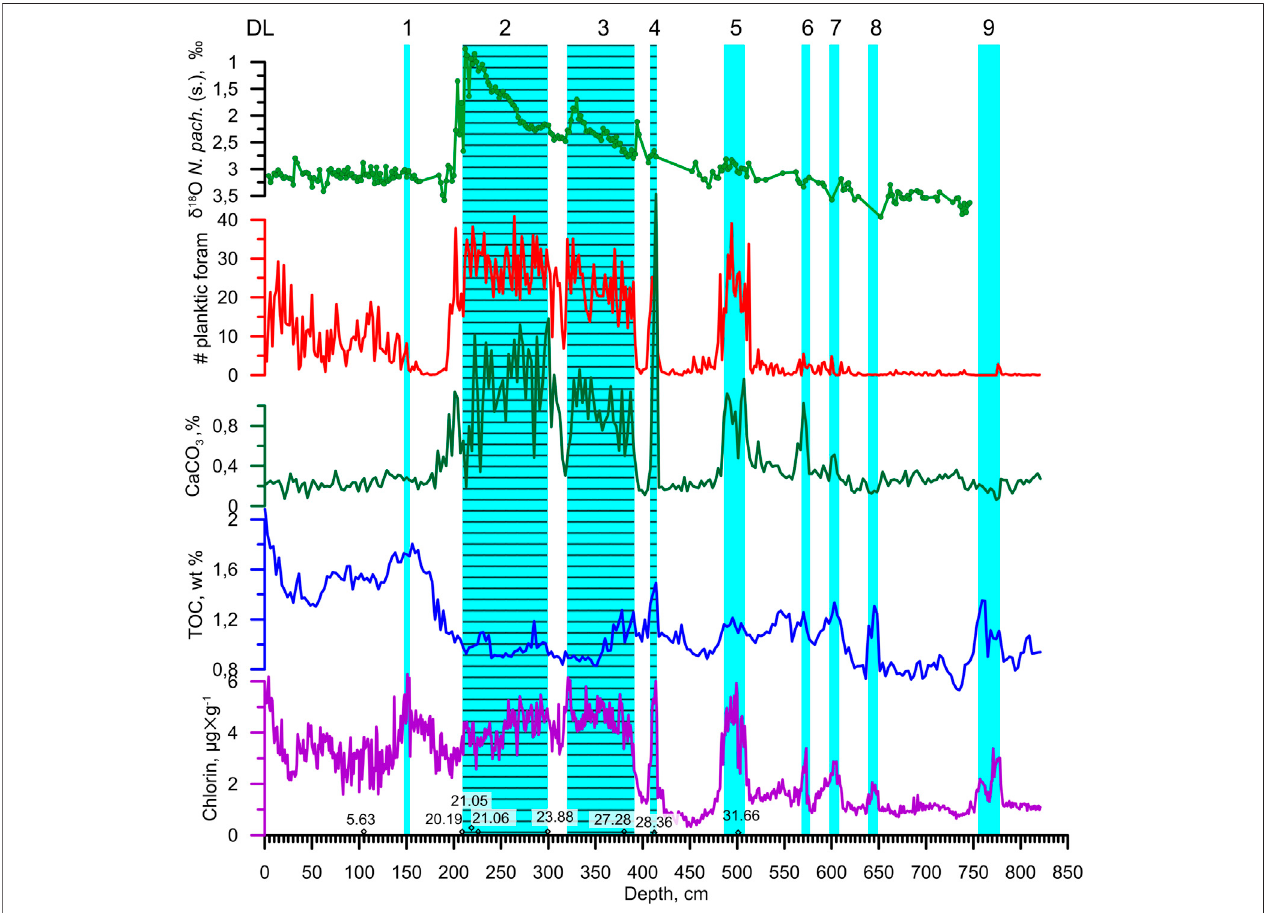
FIGURE 5 | Records of chlorin, total organic and carbonate content and photo lightness (PL), color parameter L* and δ 18 O of planktic foraminifera N. pachyderma (s.) in sediment core LV32-33 versus depth. Notation of bars and DL number is the same as in Figure 3 .